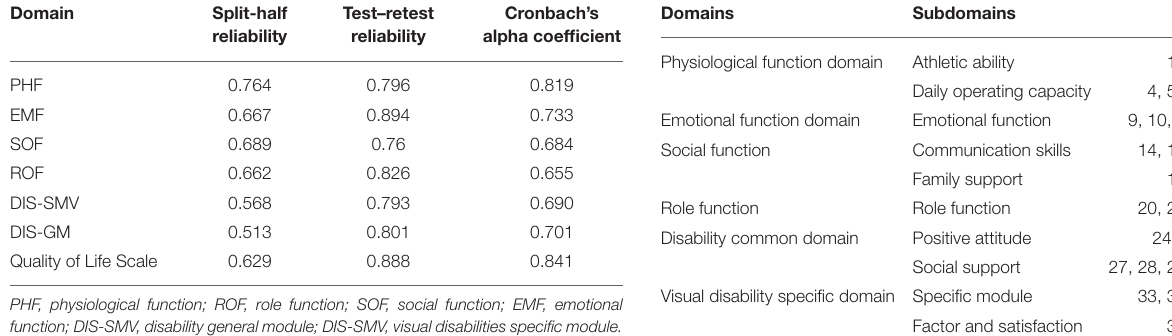
TABLE 3 | Reliability of the total scale and of each domain. Domain